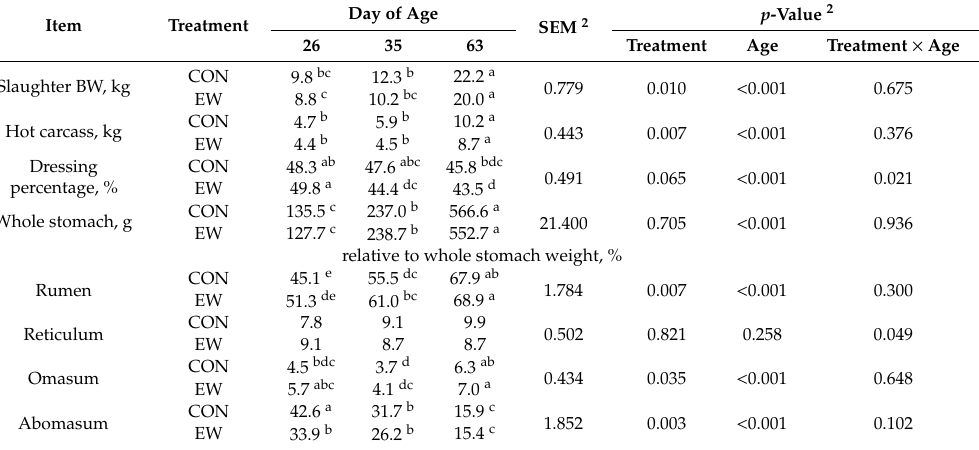
Table 2. Carcass weight, weight of rumen, reticulum, omasum, and abomasum relative to whole stomach weight on 26, 35, and 63 days of age 1 .